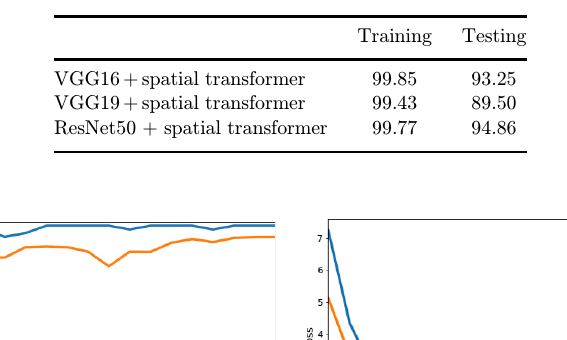
Table 5. Accuracies of di®erent pretrained models with spatial transformer model.